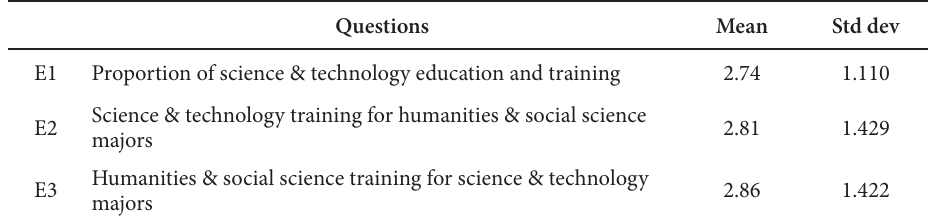
Table 10. Current status of cross-disciplinary training